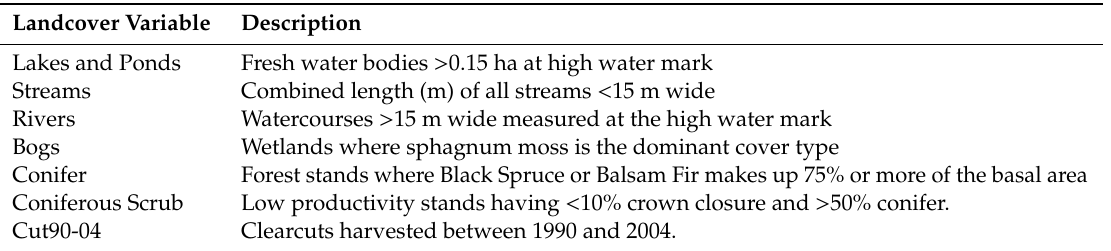
Table 1. Landcover variables used in modeling rusty blackbird occupancy in Newfoundland, Canada, 2016 and 2017. Variables were measured as either the linear amount of the feature (streams [m]) or the proportion of landcover within a 347 m radius of each survey point (all other variables).